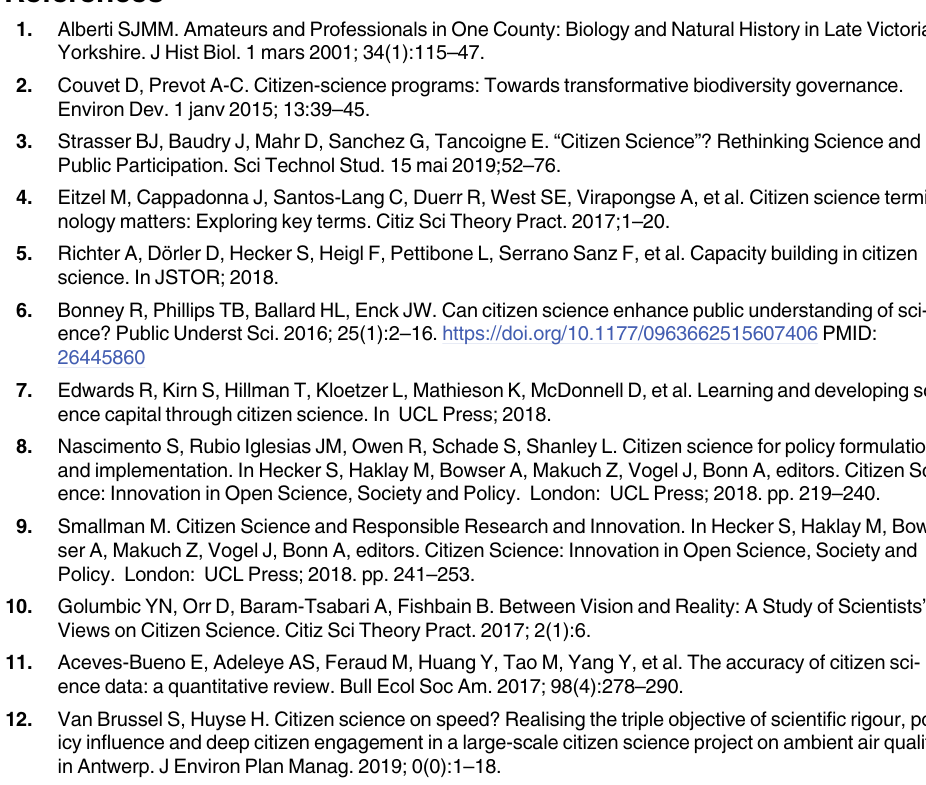
S3 Fig. Average yearly citation rate for the Vigie-Nature articles. The blue curve includes self-citations, and the red one excludes